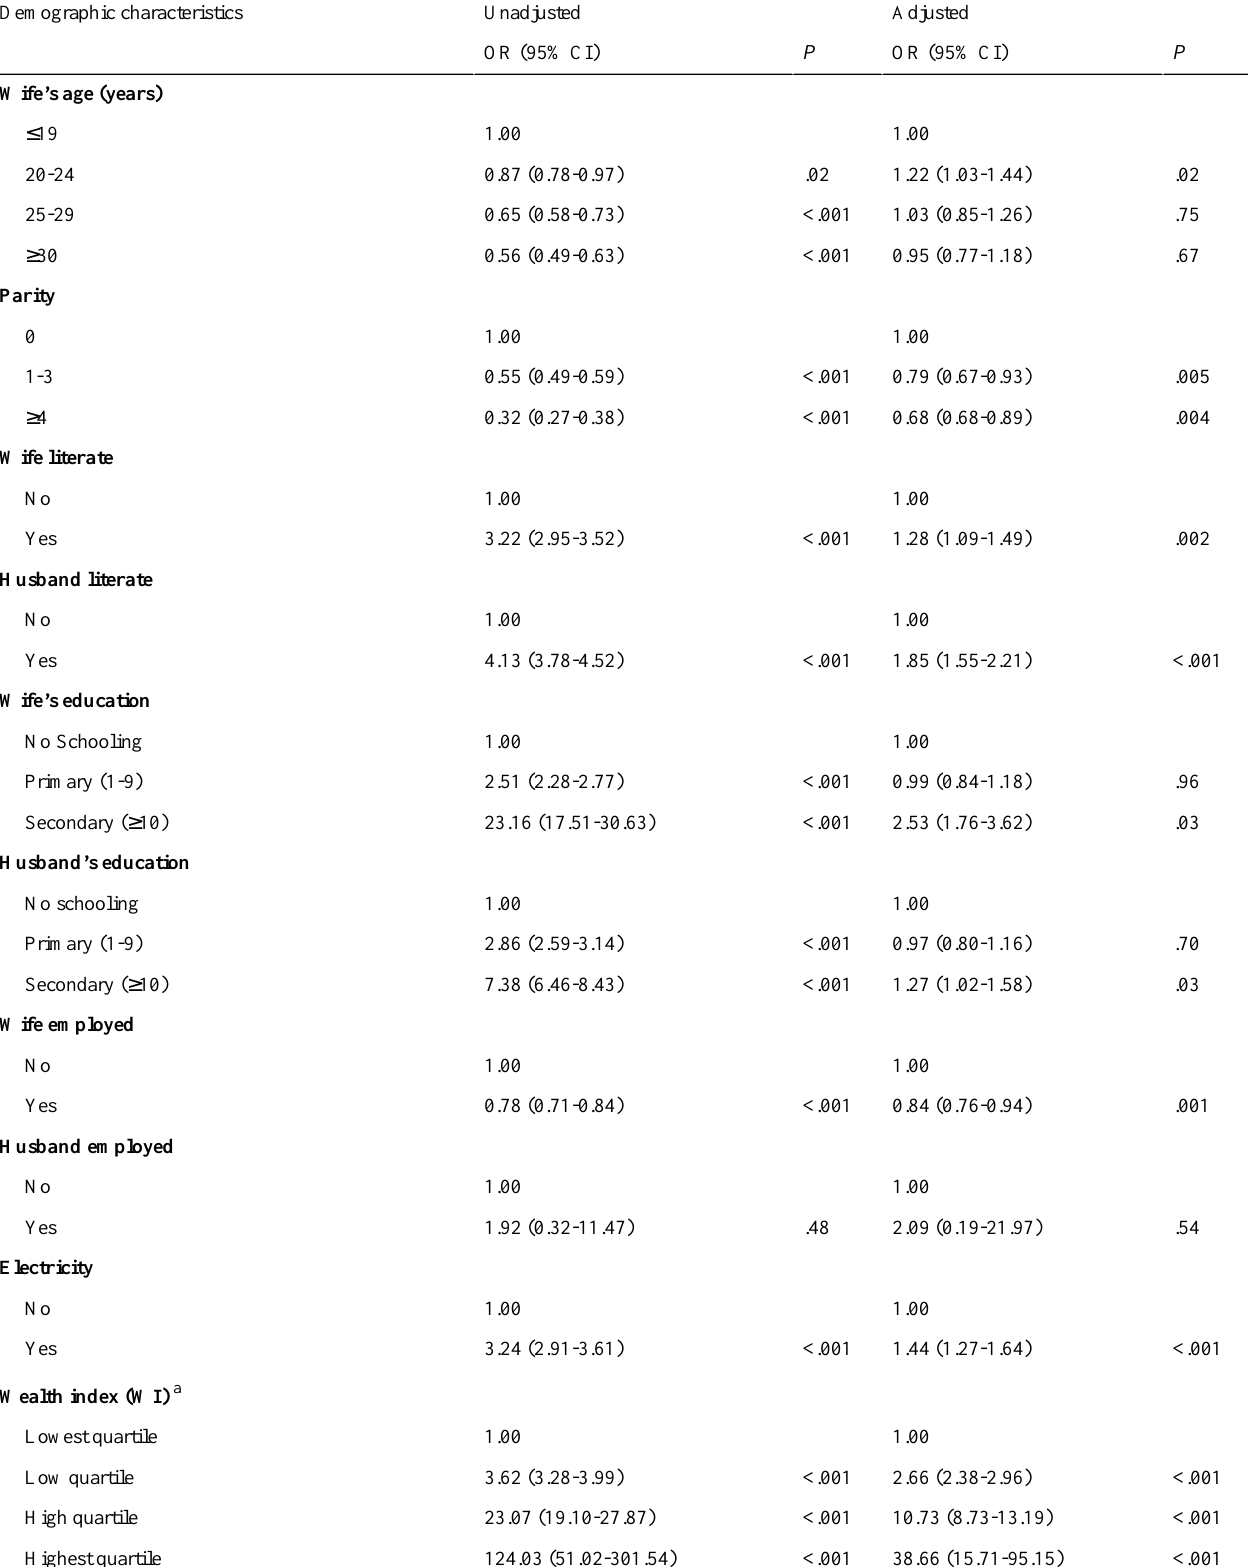
Table 6. Unadjusted and adjusted odds ratio (OR) and 95% confidence intervals (95% CI) of reporting household mobile phone ownership by demographics for fiscal year 3 (n=9109), July 2010-June